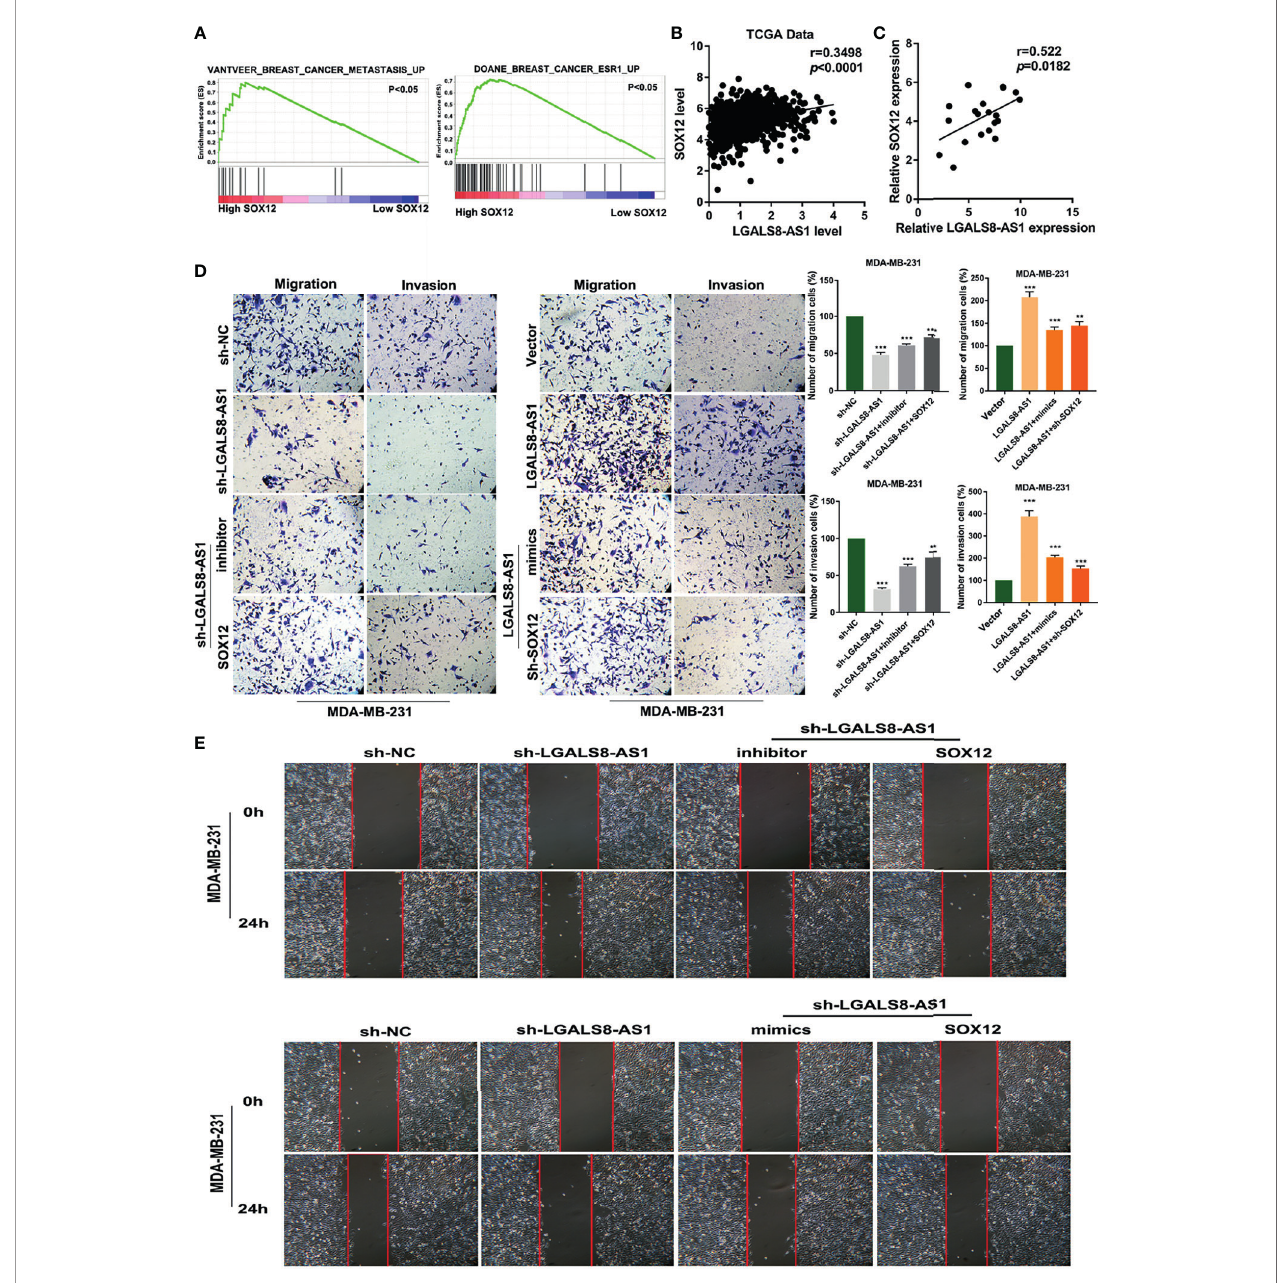
FIGURE 6 | LGALS8-AS1 promoted SOX12-mediated metastasis through decoying hsa-miR-125b-5p. (A) Gene set enrichment analysis (GSEA) revealed that SOX12 was related to metastasis in breast cancer. (B) Correlation between the expressions of SOX12 and LGALS8-AS1 in the breast cancer gene (BRCA) dataset of The Cancer Genome Atlas (TCGA). (C) Correlations between the expressions of SOX12 and LGALS8-AS1 in clinical breast cancer samples. (D, E) Combined effect of LGALS8-AS, miR-125b-5p mimics, and sh-SOX12 on the cell migration and invasion of MDA-MB-231 and MCF-7 cells determined by Transwell and scratch assays. ** p < 0.01, *** p <